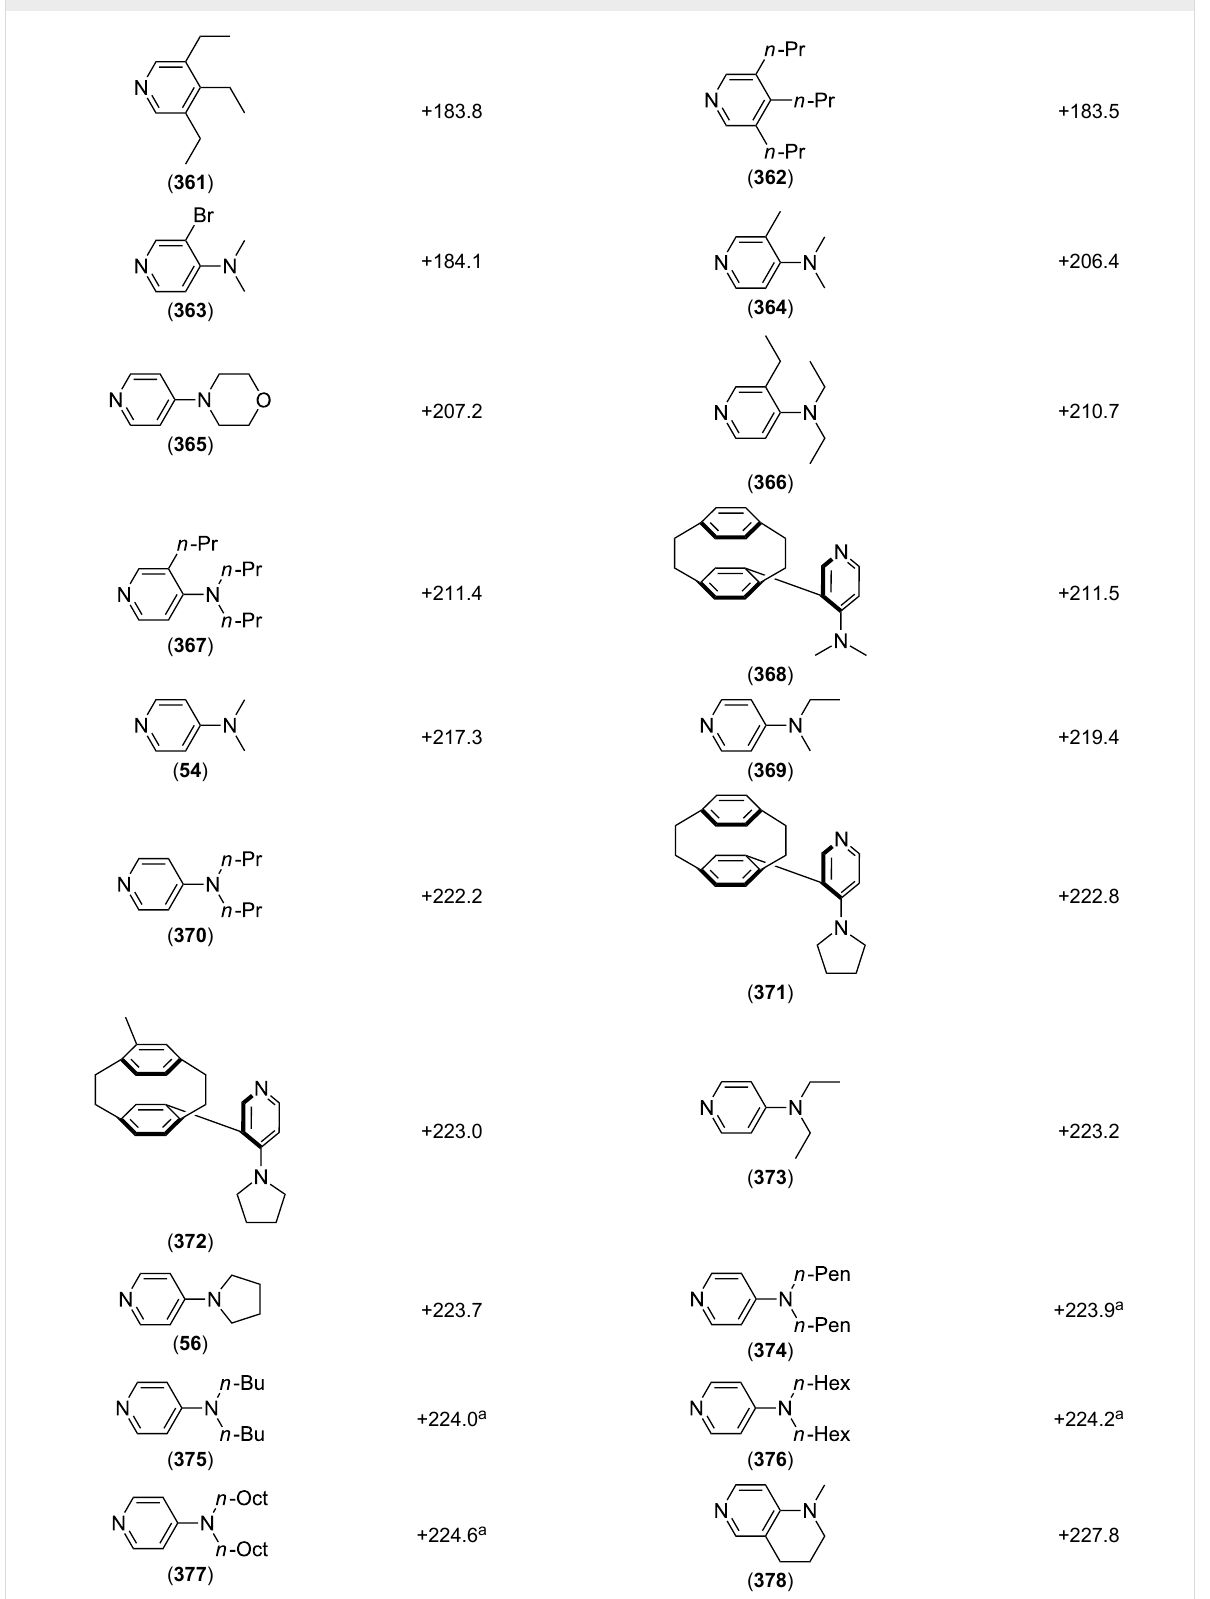
Table 13: ACA values of pyridines and 4-aminopyridines, ordered by increasing ACA values.